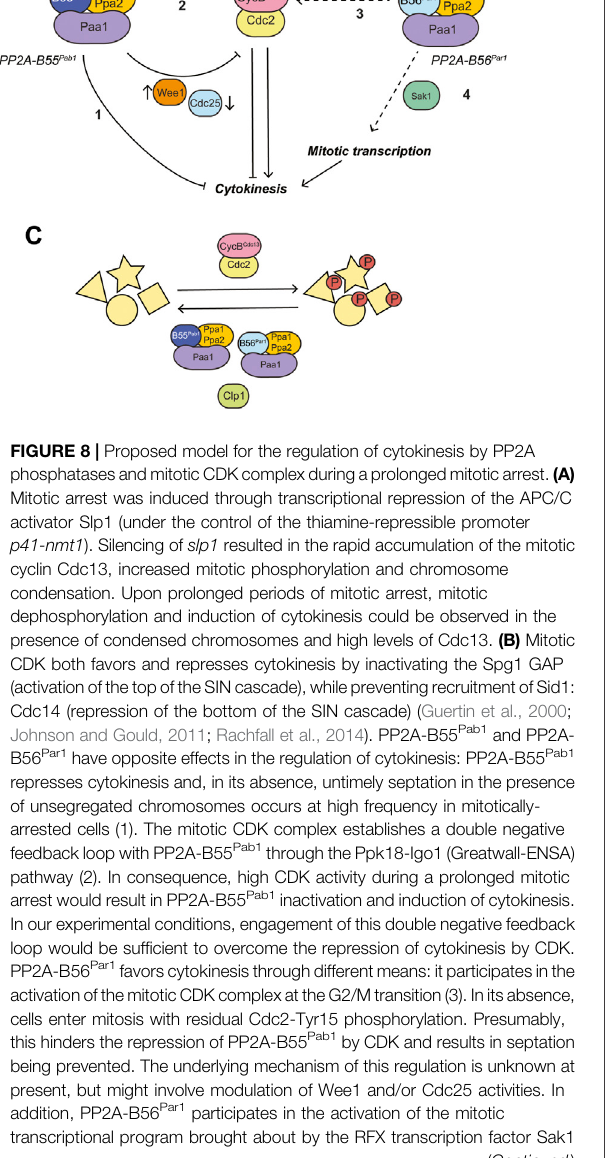
FIGURE8| (4).LossofeitherSak1orPP2A-B56 Par1 impairstheexpressionof cytokinetic regulators and this contributes to the absence of cytokinesis during the arrest in these mutants. (C) Steady mitotic dephosphorylation during the arrest requires the activities of Clp1, PP2A-B55 Pab1 and PP2A- B56 Par1